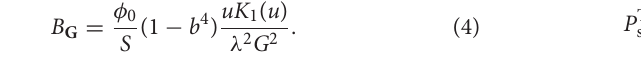
FIGURE 4 | The magnetic field distribution P ( B ) caused by formation of the flux-line lattice in NdFeAsO 0.65 F 0.35 sample in B ex experiments. The blue curves are obtained by subtracting the symmetric background peak (see text for